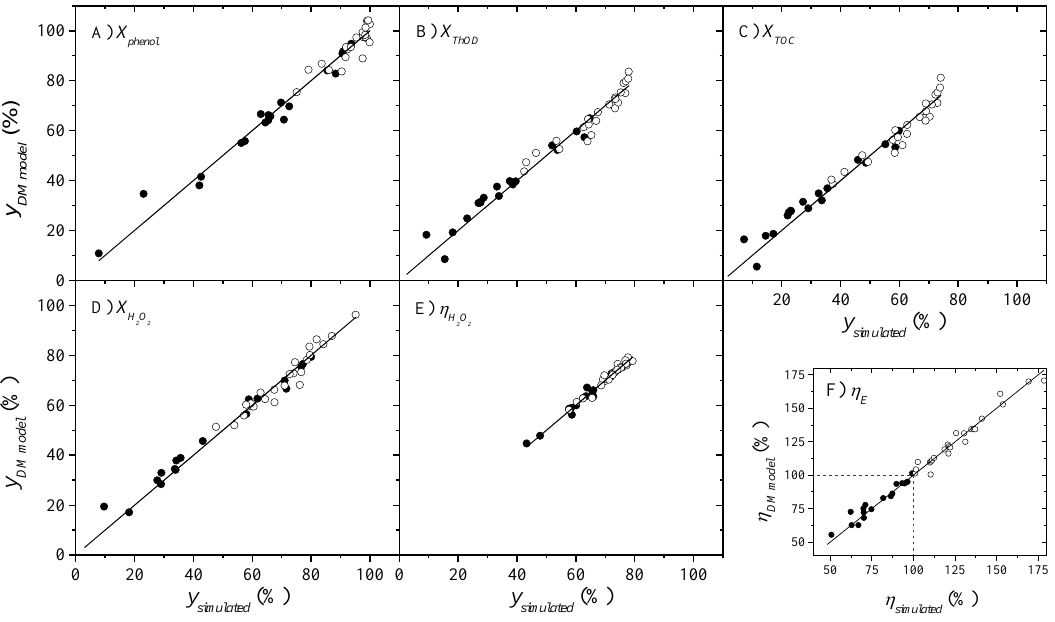
Figure 3. Parity plots comparing the six response variables ( A – F ) predicted by the quadratic model and by the ASPEN Plus ® v11 simulator. Open symbols represent the cases under autothermal operation.